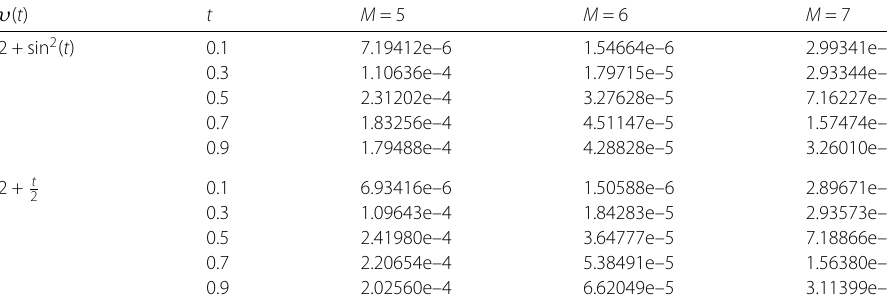
Table 1 Comparison of the absolute errors (AEs) for Example